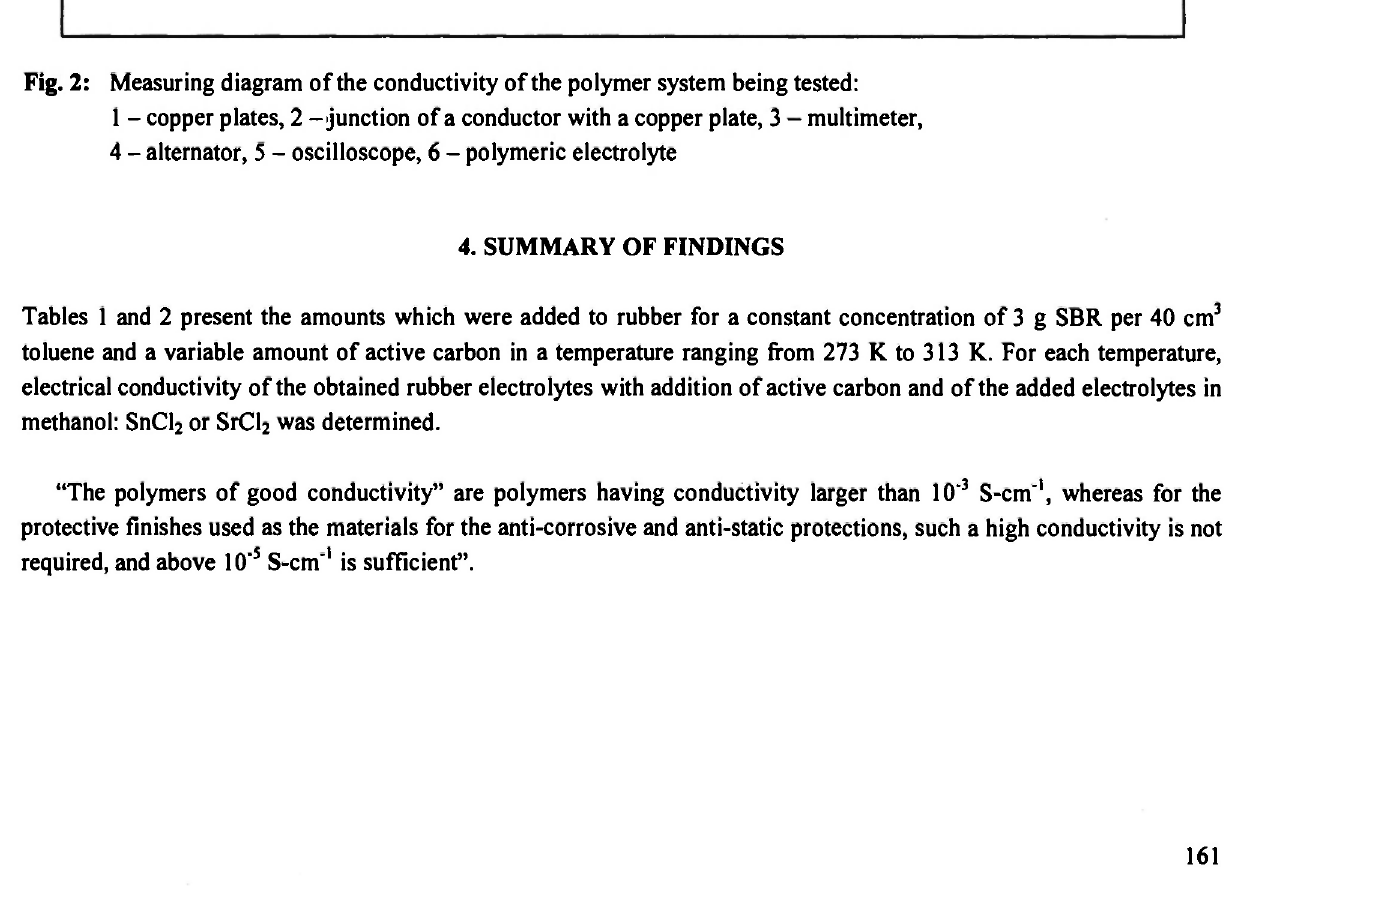
Fig. 2: Measuring diagram of the conductivity of the polymer system being tested: 1 - copper plates, 2 - junction of a conductor with a copper plate, 3 - multimeter, 4 - alternator, 5 - oscilloscope, 6 - polymeric